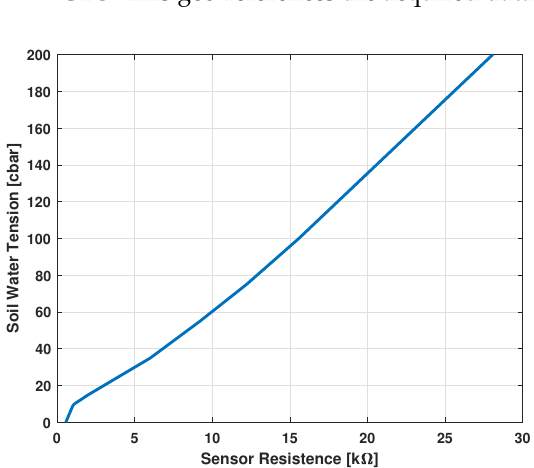
Figure 5. Soil moisture sensor characteristic.